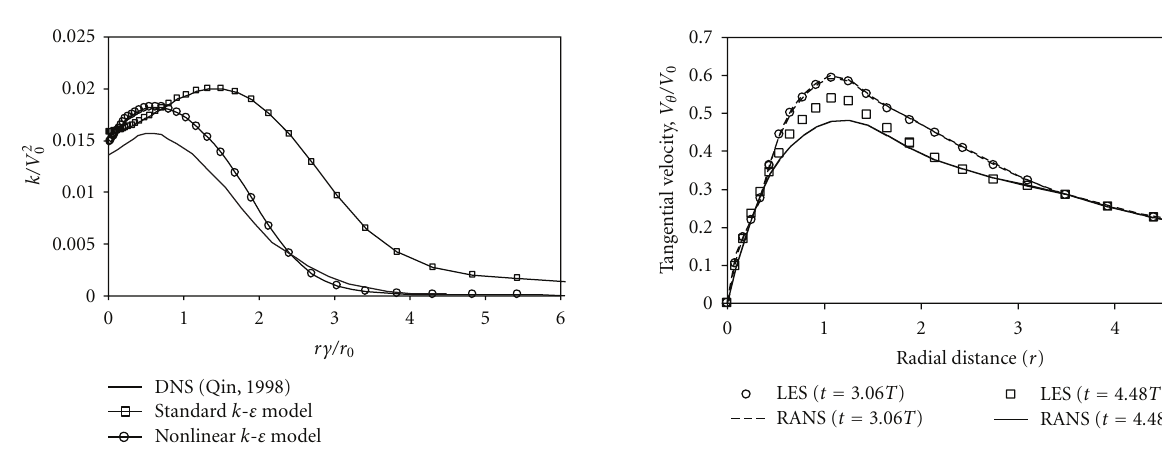
Figure 8: k - ε model prediction of turbulent kinetic energy compared with Qin’s DNS results ( t = 3.72 T ).